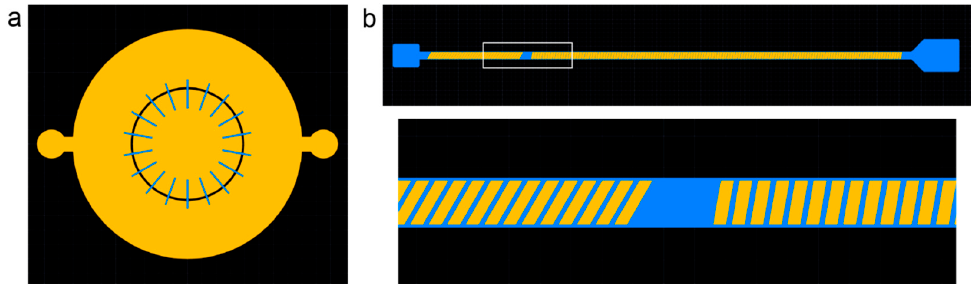
Figure 3. Dark-field mask layouts for chemotaxis and hydrophoresis devices. ( a ) Neuronal chemo- taxis device consists of a 10 µm channel layer (blue) and a 100 µm chamber layer (orange). Note that the second layer mask pattern (orange) also crosslinks the first resist layer. ( b ) Hydrophoresis sorting